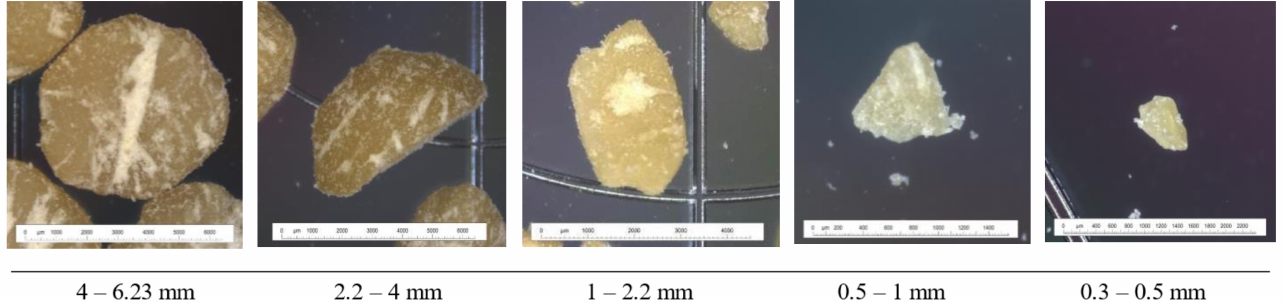
Figure 2. Granulometry of the fractions obtained by sieve analysis on dehulled beans with 2D